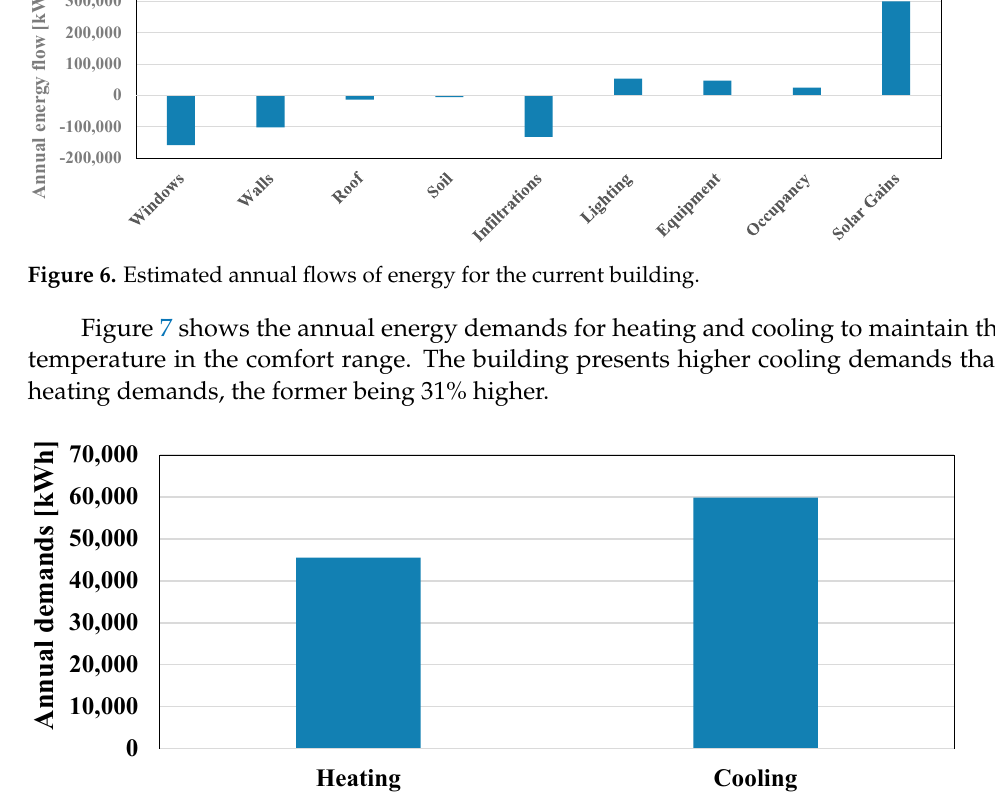
Figure 7. Annual energy demands for heating and cooling in the current building.